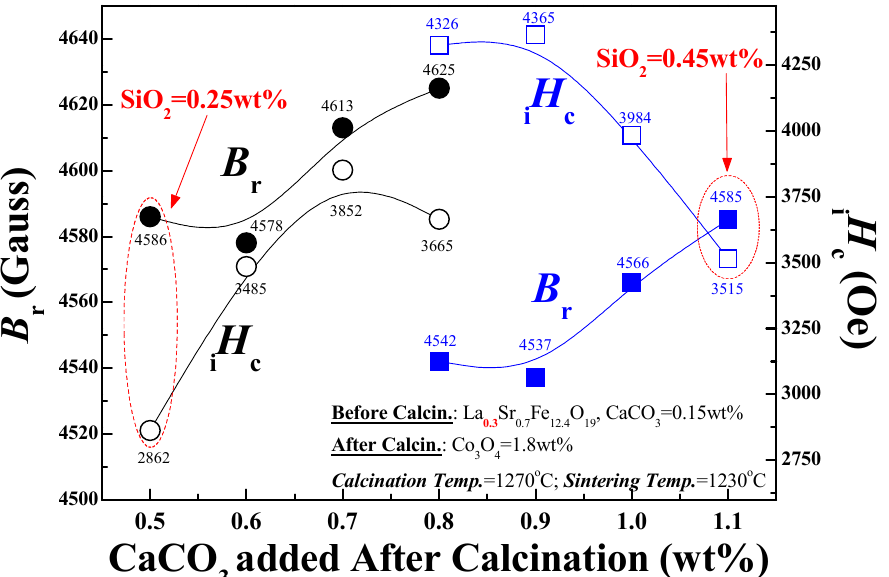
Figure 8. Dependence of B r and i H c of the sintered magnet on the amount of CaCO 3 added after the calcination process.